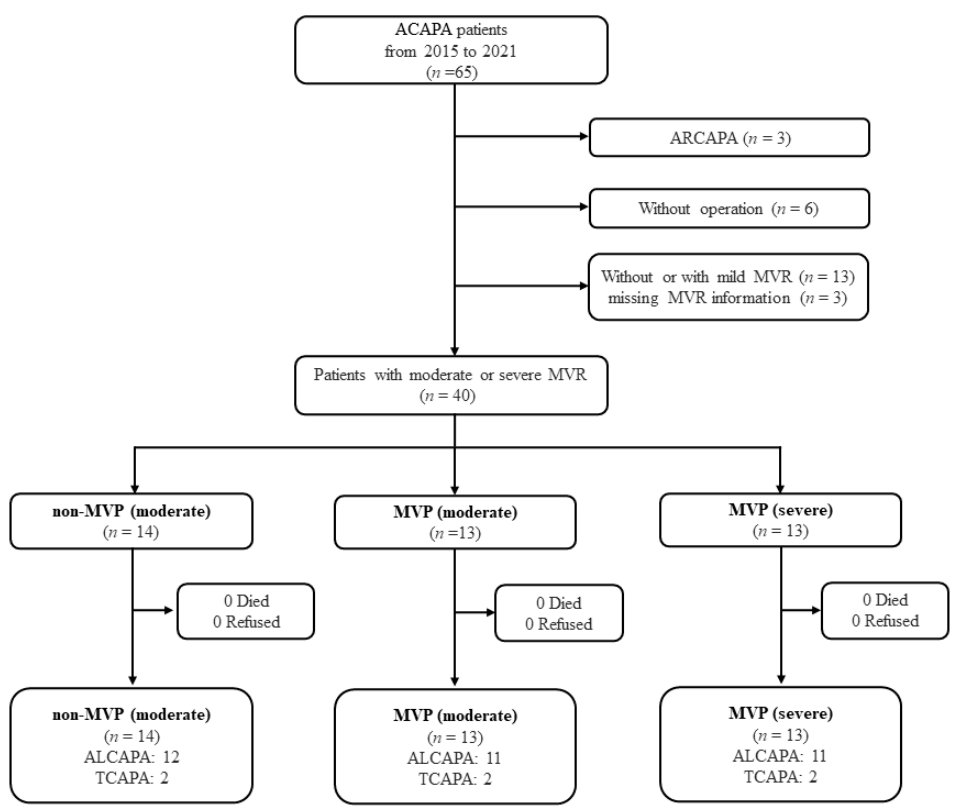
Figure 1. Flow chart of patient selection and follow-up. Abbreviation: ALCAPA, anomalous origin of the left coronary artery from the pulmonary artery; ARCAPA, anomalous origin of the right coronary artery from the pulmonary artery; MVR, mitral valve regurgitation; MVP, mitral valve plasty; TCAPA, total anomalous origin of the coronary arteries from the pulmonary artery.